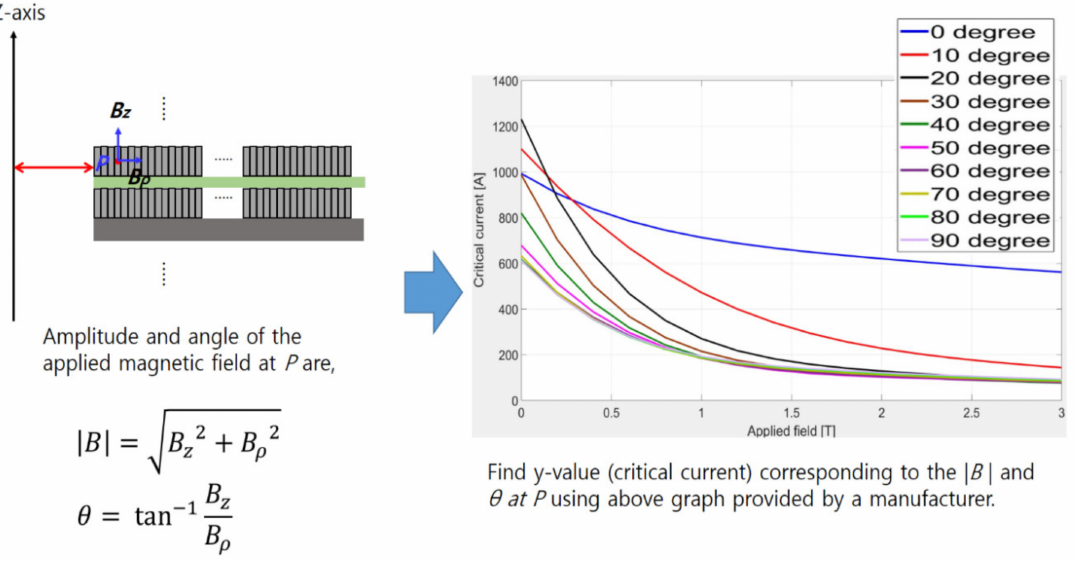
Figure 5. Details of the critical current calculation